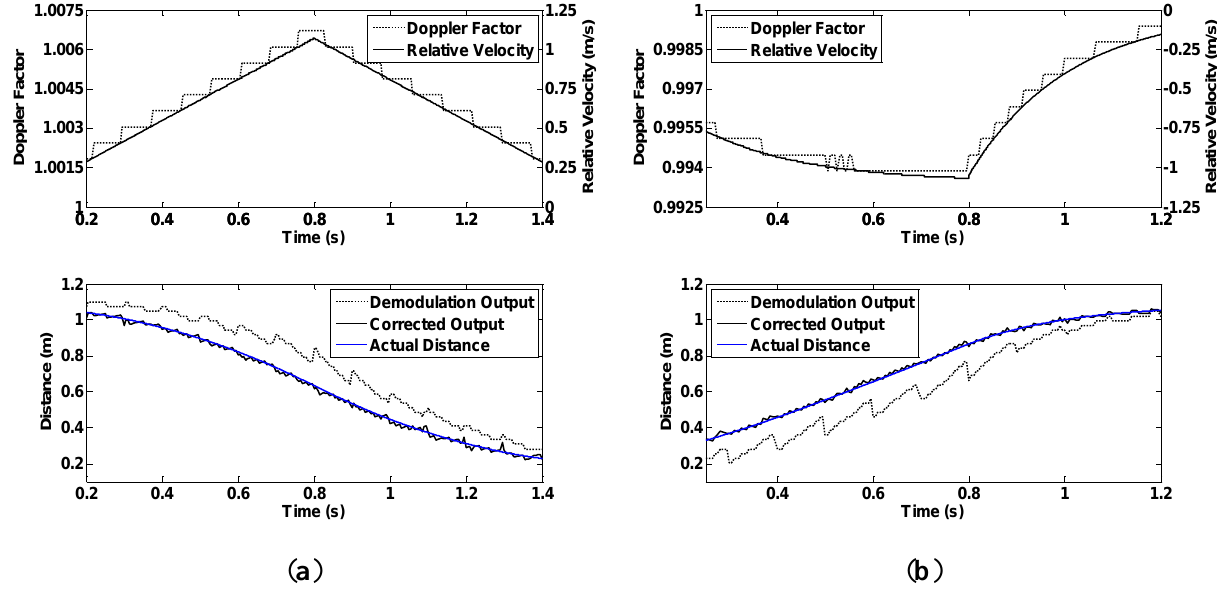
Figure 10. Experiment results of condition 1, the speed of the sonar head changes ( a ) linearly; and ( b )